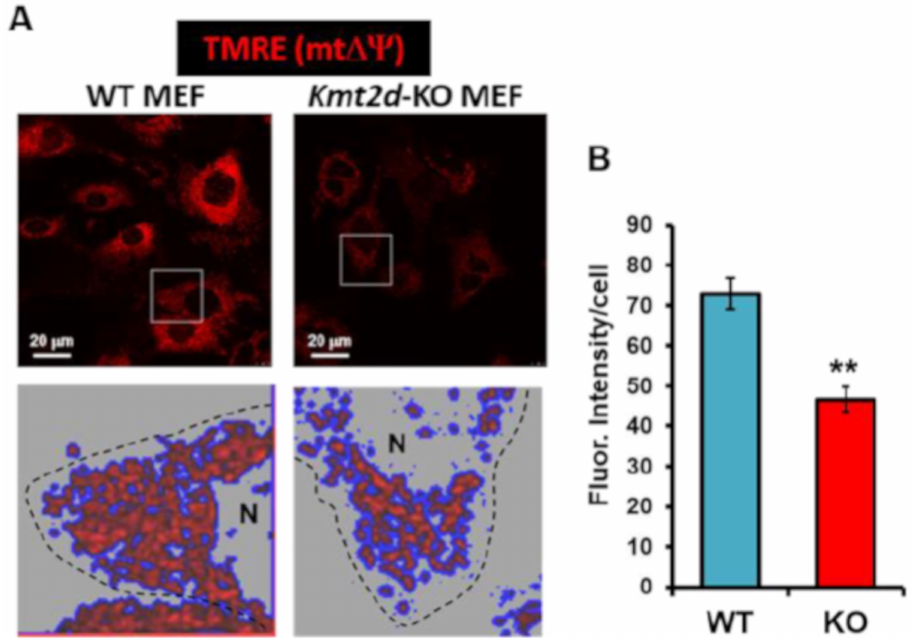
Figure 3. Imaging of the mitochondrial membrane potential in WT and Kmt2d -KO MEF. Cells pre-incubated with TMRE were analyzed by confocal microscopy. ( A ) Representative images with false-color rendering of digitalized magnifications; N, nucleus. ( B ) Quantitative analysis of the TMRE fluorescence intensity / cell expressed in arbitrary units; the bars are means ± SEM of three independent experiments; **, P < 0.005. For each condition, at least 10 di ff erent optical fields were randomly selected containing 10–15 cells each. See the materials and methods for further